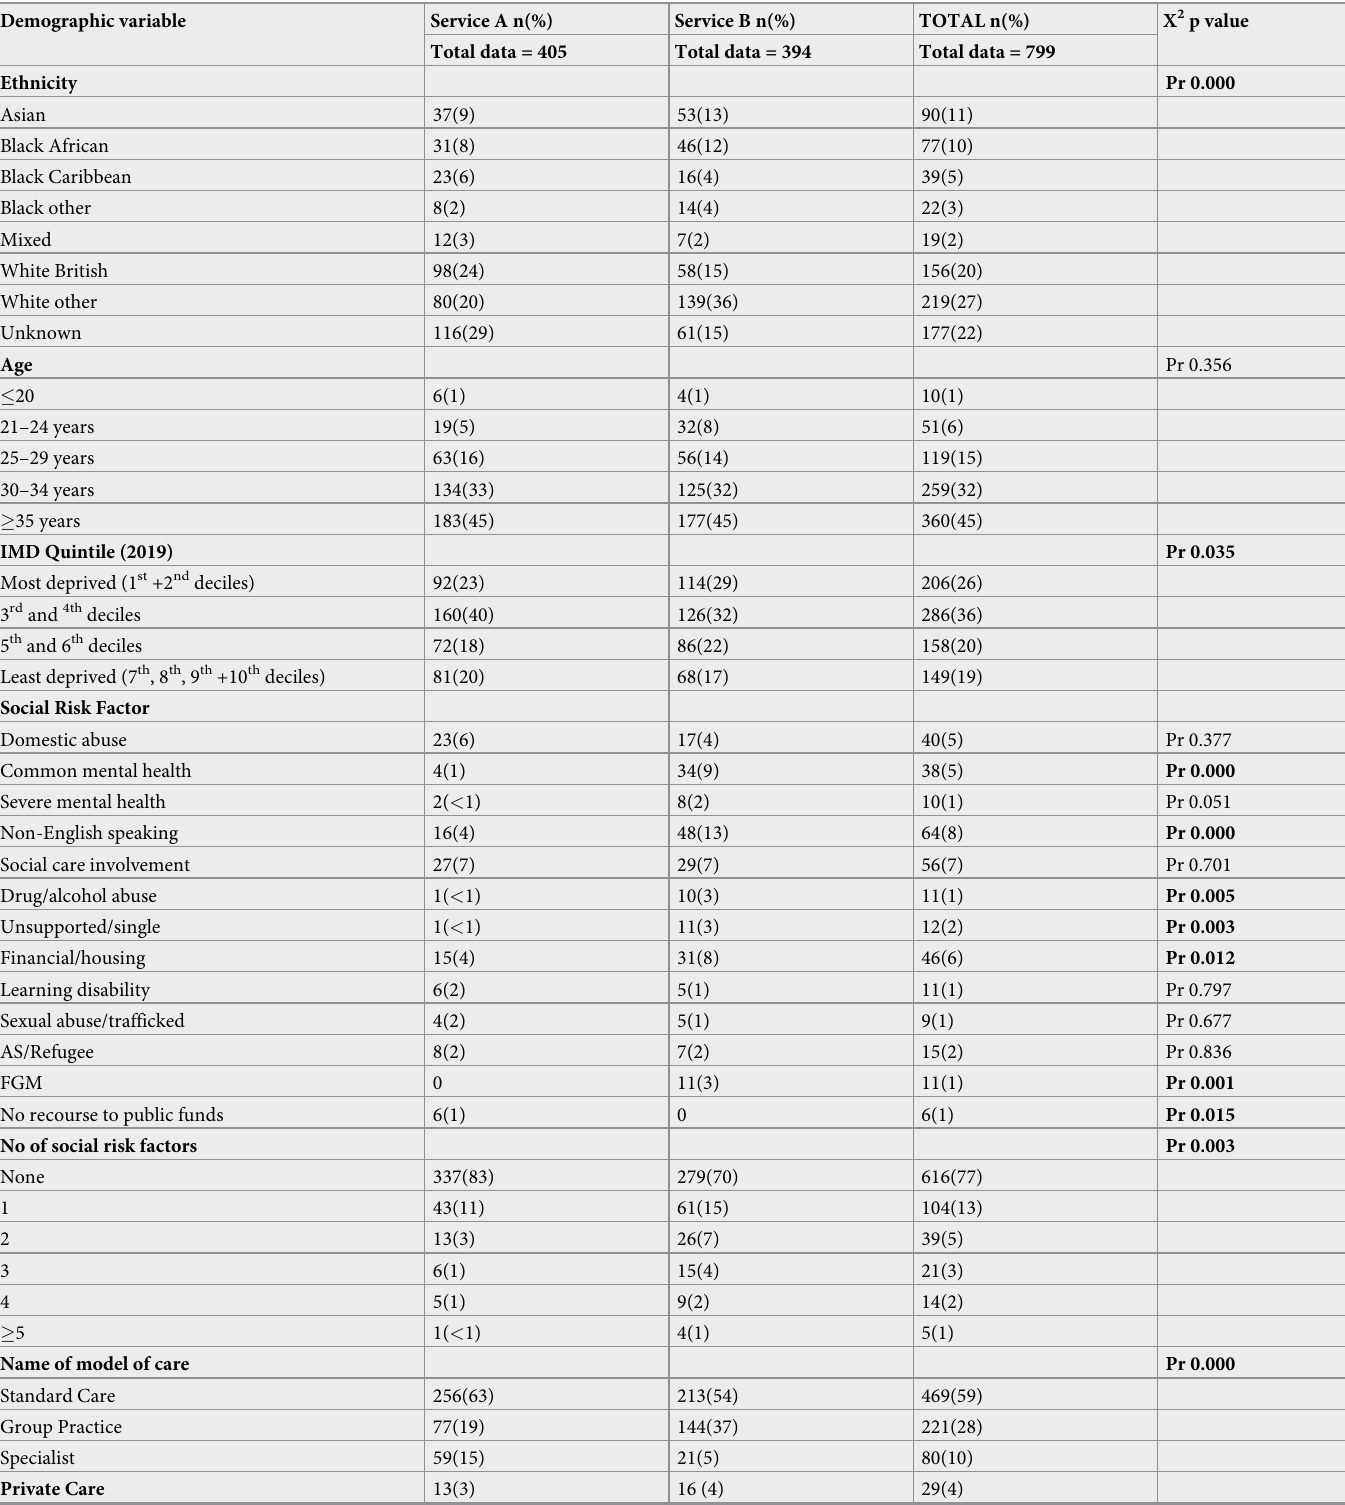
Table 3. Women’s demographics at each service